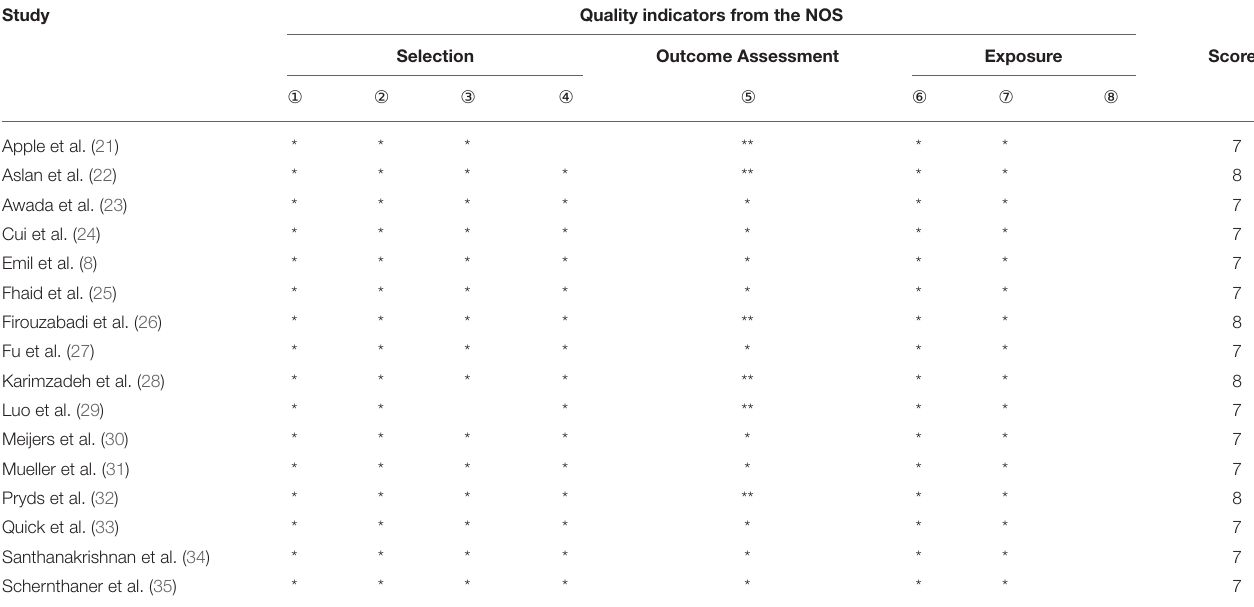
TABLE 2 | NOS score of included studies. Study